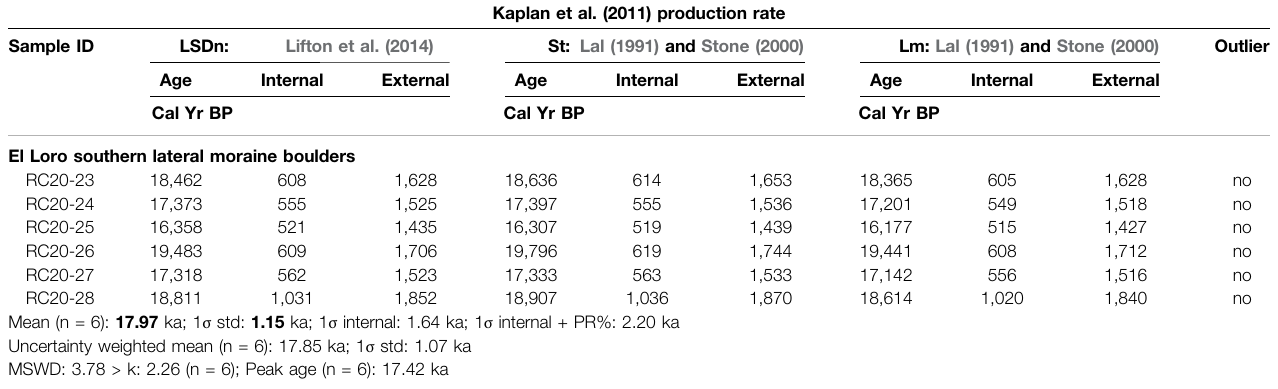
Kaplan et al. (2011) production rate